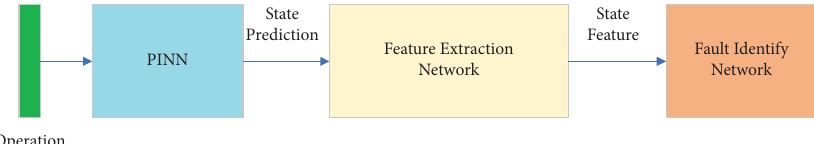
Figure 1: Tree components of EDN-NPSP.